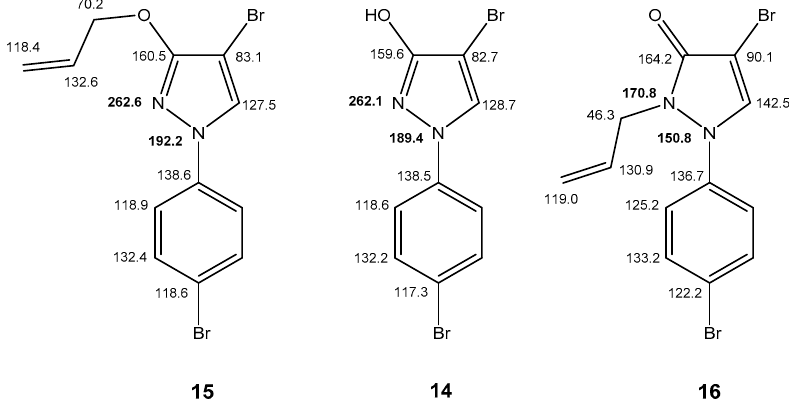
Figure 7. 1 H (in italics), 13 C and 15 N (in bold) NMR chemical shifts of 14 and its “fixed” derivatives 15 and 16 (in CDCl 3 ).